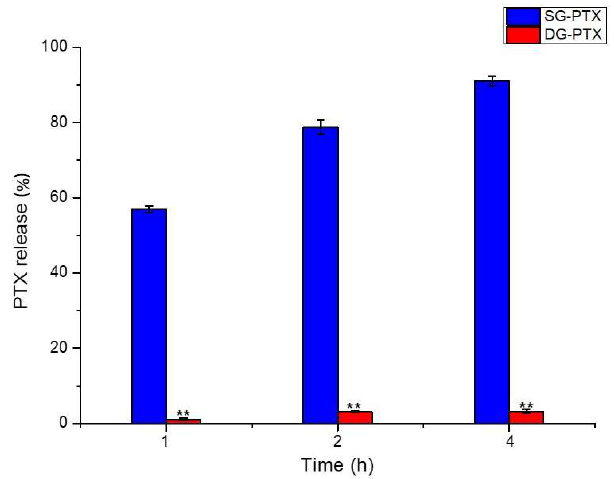
Figure 4. Enzymatic hydrolysis of SG-PTX and DG-PTX. All values are expressed as mean ± SD (n = 5). Compared to SG-PTX group, ** p < 0.01.